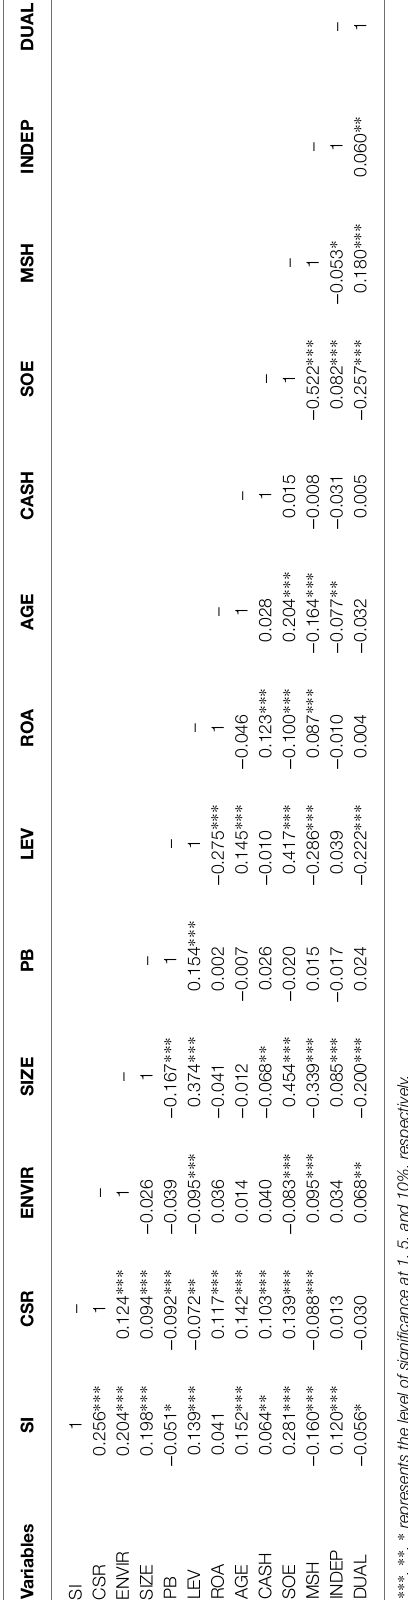
TABLE 4 | Regression results of sustainable innovation and